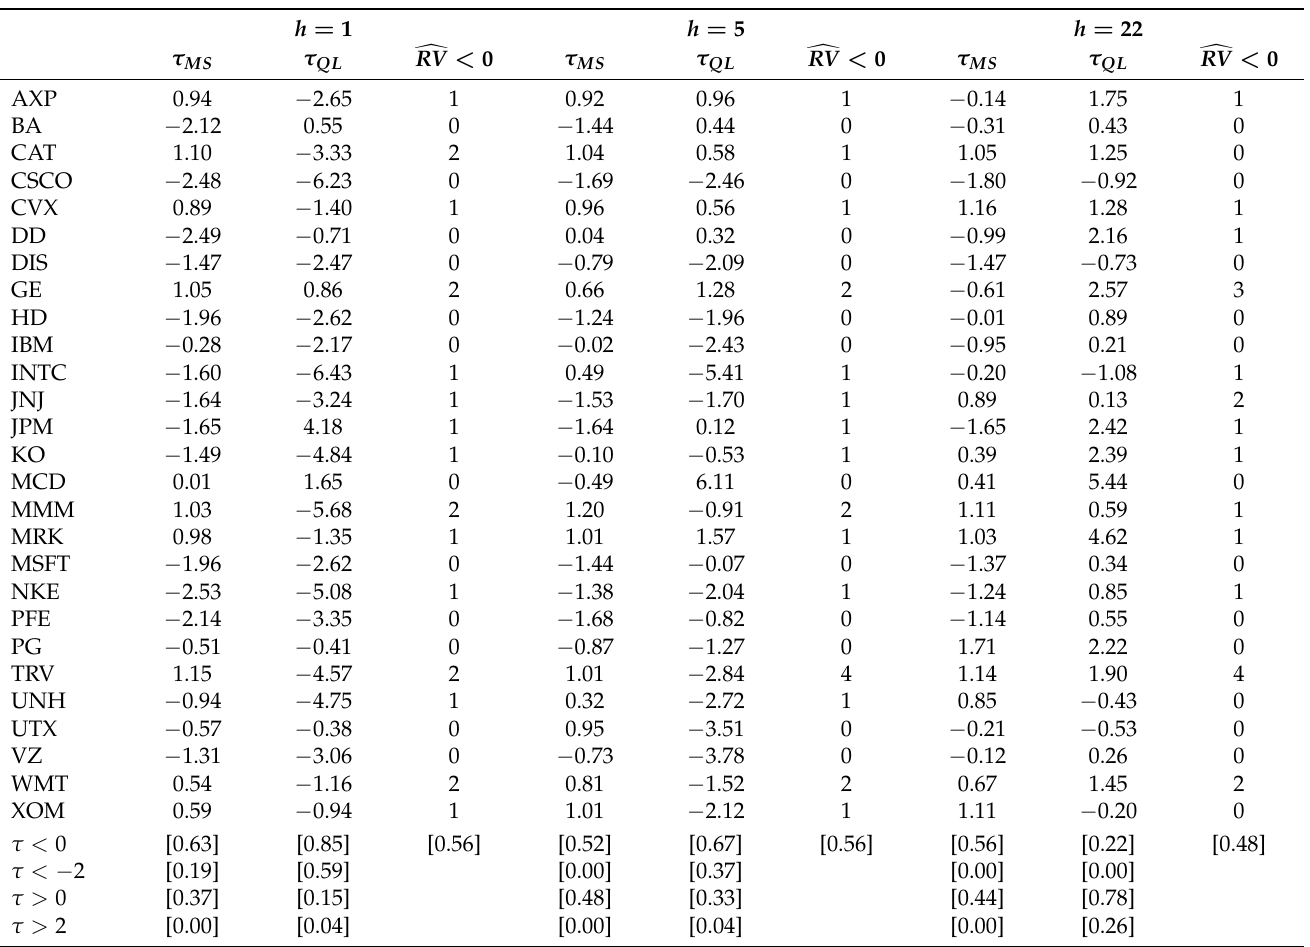
Table 1. t -ratios of Diebold and Mariano [27] test of equal predictive accuracy of h -step RV rolling forecasts. The baseline forecast from the HARQ model (no transformation) is compared against the forecast from the exponential transform of the log forecast from model (Section 3.1) assuming log-normality. A positive τ value indicates a better forecast from the comparison model against the baseline HARQ forecasts. τ MS for equality of mean squared error loss and τ QL for QLIKE loss of Patton [24]. (cid:99) RV < 0 is the number of negative forecasts (in the forecast sample) produced by the HARQ model. The bottom four rows are the fraction out of 27 stocks that satisfy the inequalities; for (cid:99) RV < 0, it is the fraction of 27 stocks that produced at least one negative forecast. The rolling forecasts are generated with a rolling estimation window of 8.67 years (104 months) followed by a one-month prediction window shifted each month over 96 windows. The forecast sample is from